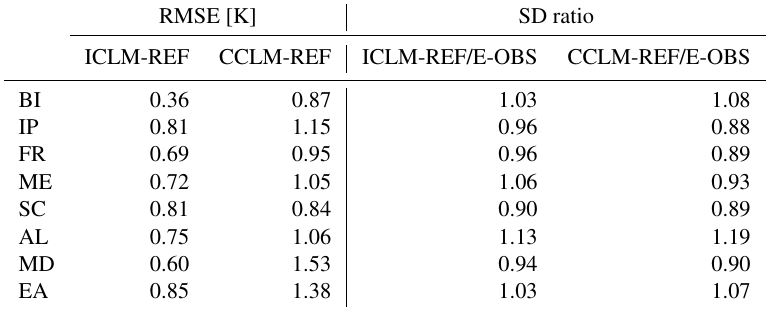
Table 5. Same as Table 4 but for minimum 2m temperature.